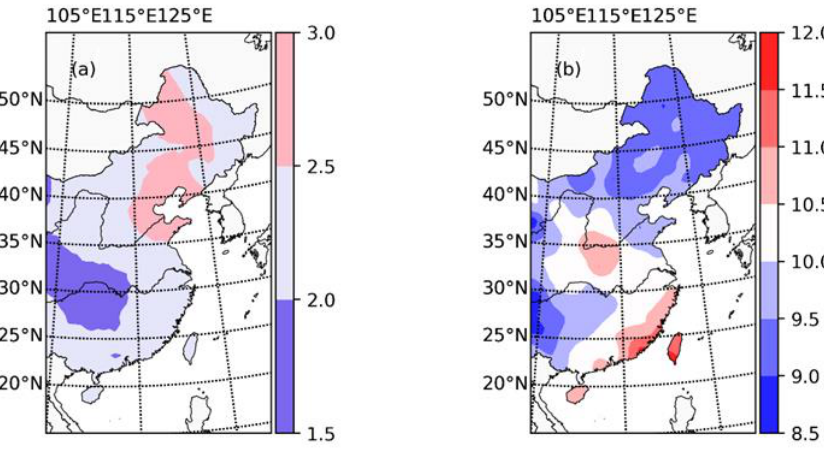
Figure 7. Spatial distribution 𝜏̅ 𝑞 : ( a ) UPEs and ( b ) EPEs.